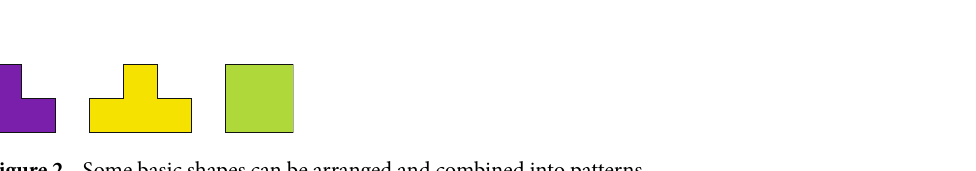
Figure 1. Some patterns (including fish, pistol and robot) formed by the combination of basic shapes.